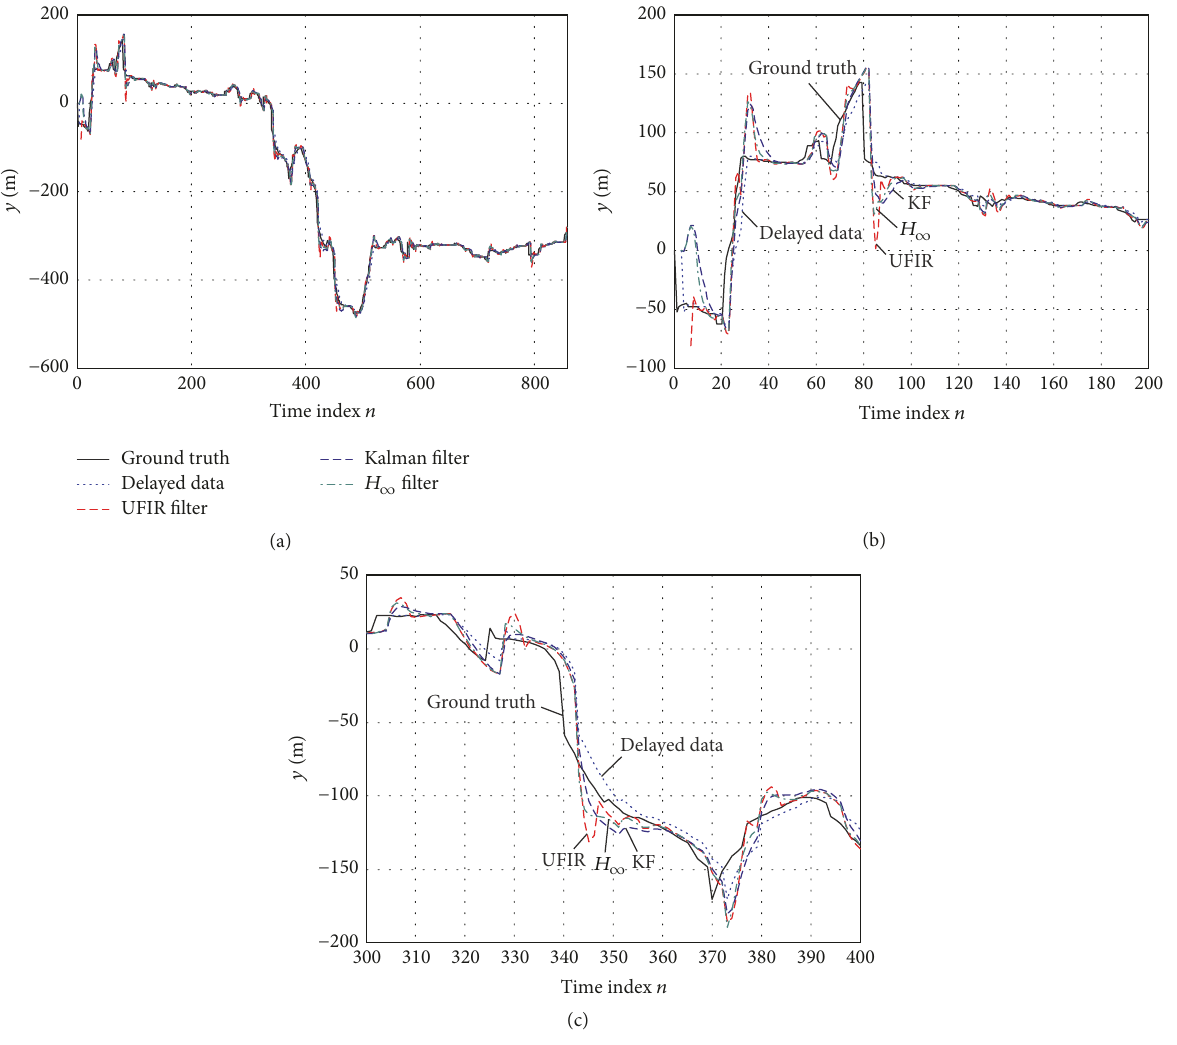
Figure 4: Tracking in the north direction 𝑦 , 𝑚 for 𝑘 = 3 with UFIR filter ( 𝑁 opt = 5 ), KF, and 𝐻 ∞ filter ( 𝜃 = 3.3 × 10 −4 ): (a) full time scale, (b) 0 ⩽ 𝑛 ⩽ 200 , and (c) 300 ⩽ 𝑛 ⩽ 400